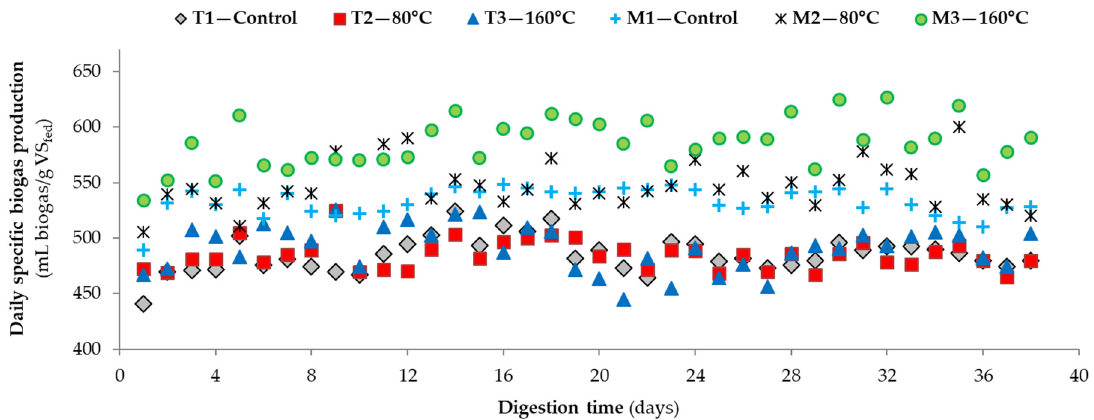
Figure 1. Evolution of specific biogas yields of thermophilic and mesophilic digesters during the operating period after reaching a steady state (0°C and 1 atm).